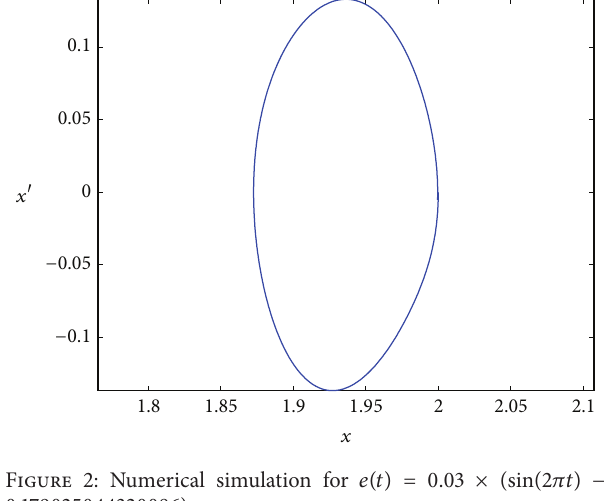
Figure 2: Numerical simulation for 𝑒(𝑡) = 0.03 × (sin(2 𝜋𝑡 ) −